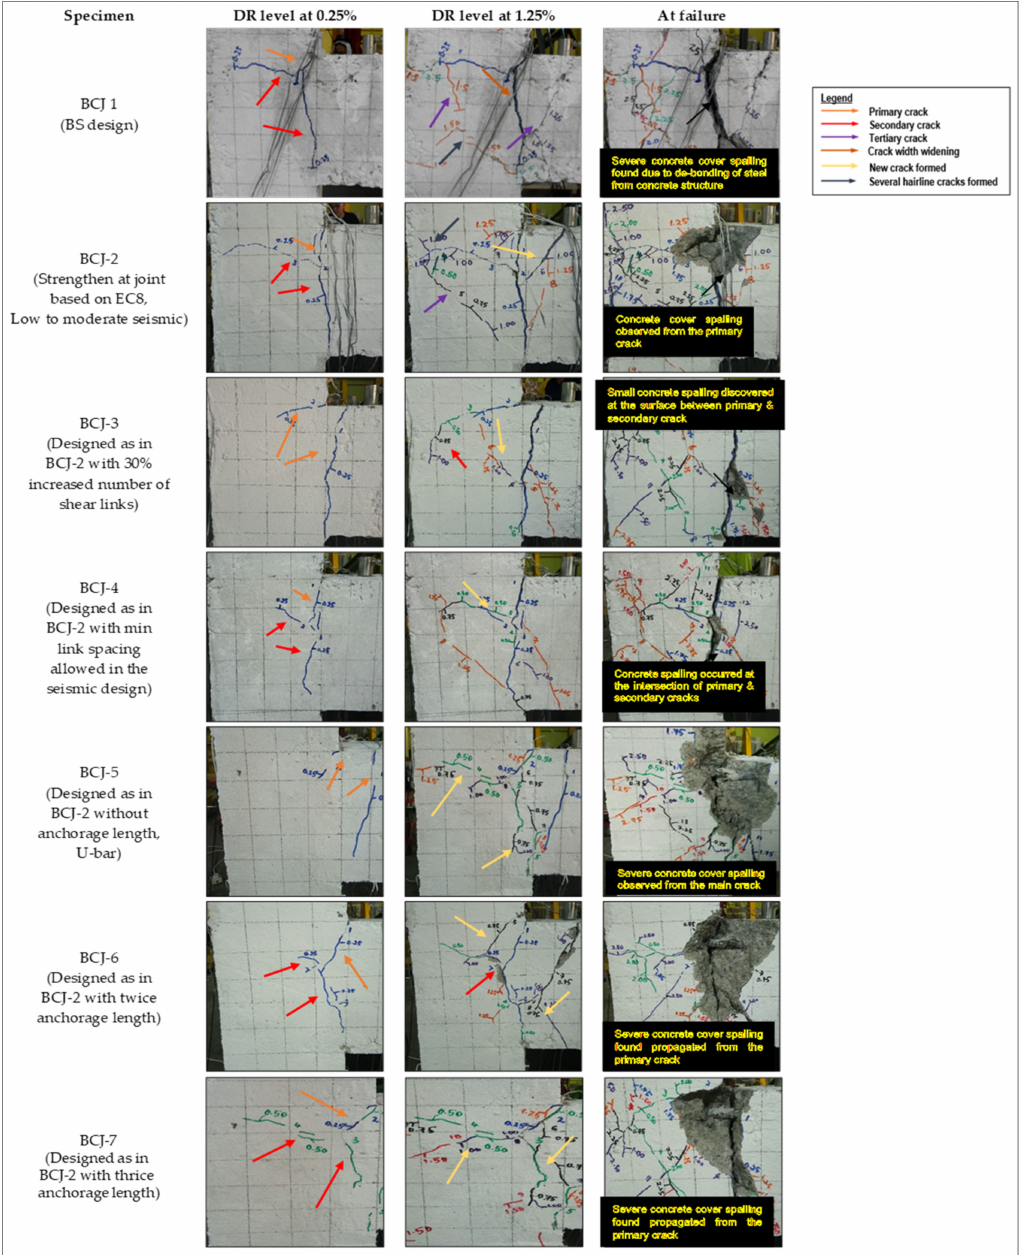
Figure 5. Crack patterns and damage of respective